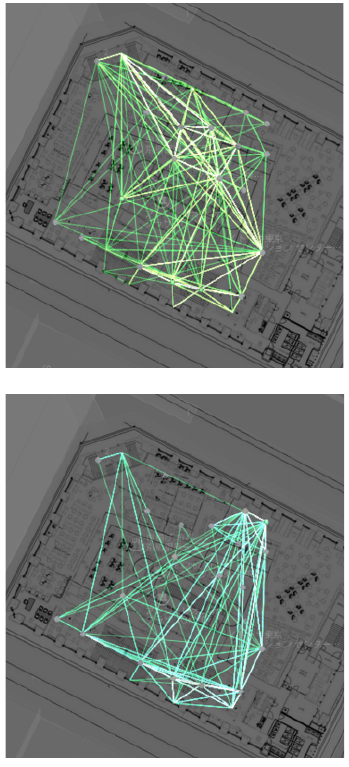
Figure 7. Spider graph of worker movement 4.3.4 Worker movement visualization as a movie: Figure 8 shows a screenshot of a video that displays worker movement. This visualization expresses the lines in Figure 7 as a moving object. This visualization expresses worker movement more graphically. Moreover, this visualization can express the worker’s movement direction.